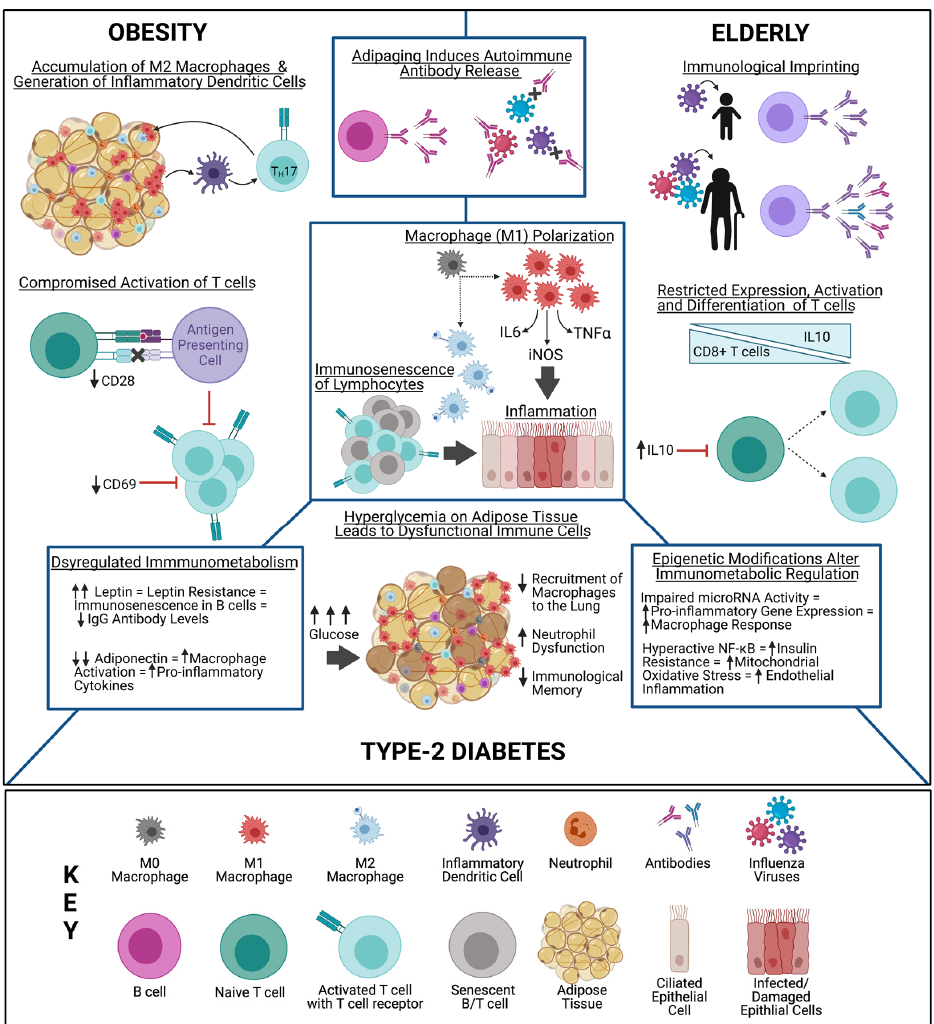
Figure 1. There is a significant overlap between immune responses observed in people with obesity, type 2 diabetes mellitus, or advanced age. The unique immune environment significantly impacts influenza vaccine efficacy among these high-risk populations. Created with Biorender.com.